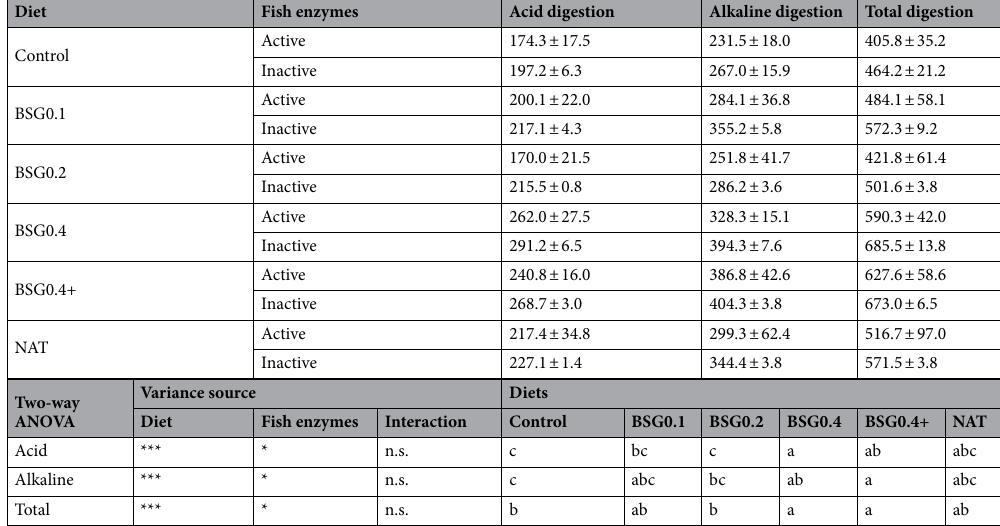
Table 5. Pentoses release (µg g −1 diet h −1 ) during the gastric, intestinal, and total in vitro digestion. Values presented as mean (n = 3) and standard deviation (SD). Two-way ANOVA testing for the effect of the diet (control, BSG0.1, BSG0.2, BSG0.4, BSG0.4 + ; NAT) and fish enzymes (active and inactive): * p < 0.05; *** p < 0.001; n.s.: not significant.